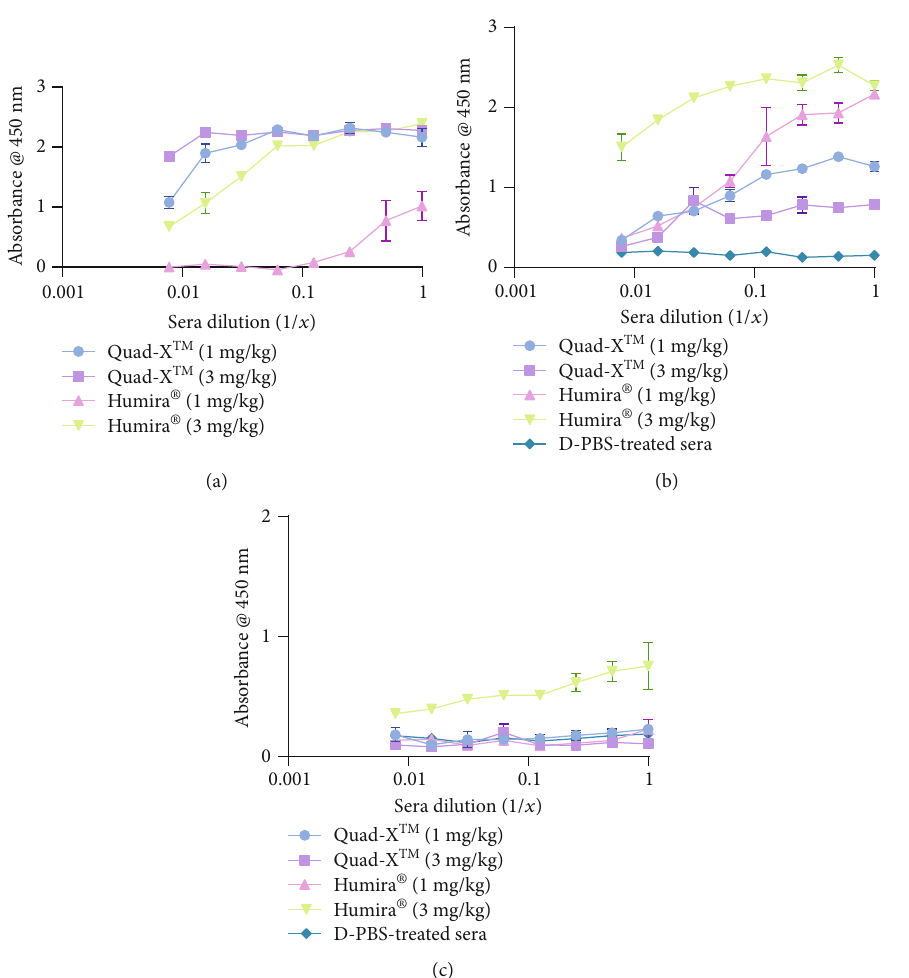
Figure 1: Drug and mouse ADA detection using an indirect capture ELISA. (a) Serum anti-hTNF- α Quad-X ™ and Humira® were detected using a capture anti-human IgG antibody (Fc speci fi c) and a detection secondary anti-human IgG antibody- (Fc speci fi c) peroxidase. (b) Detection of mouse ADA to anti-hTNF- α Quad-X ™ and Humira® using a capture anti-human IgG antibody (Fc speci fi c) and detection with an anti-mouse IgG- (whole molecule) peroxidase. (c) Detection of anti-hTNF- α Quad-X ™ and Humira® to drug-speci fi c mouse IgG using a capture anti-mouse IgG antibody (Fc speci fi c) and a detection antibody, an anti-human IgG antibody- (Fc speci fi c) peroxidase. All serum samples were randomly pooled and diluted at 1 :20 in sterile PBS, pH 7.4. The results shown are the mean ± SD ( n = 2 with two replicates per